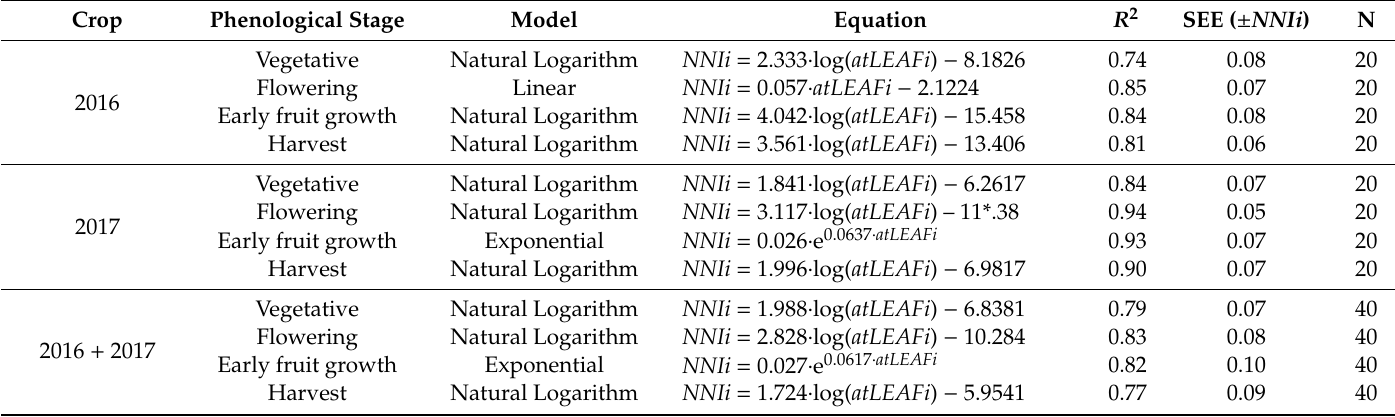
Table 7. Coe ffi cients of determination (R 2 ) of regressions between integrated atLEAF ( atLEAFi ) values and integrated nitrogen nutrition index ( NNIi ) for each phenological stage in each of the two sweet pepper ( Capsicum annuum ) crops independently and for the two crops together. Each crop was subjected to five di ff erent N treatments with four repetitions. According to the Akaike information criterion, the best-fit regression model (exponential, linear, power, quadratic, and natural logarithm) is shown. Also, it is presented the fitted equation and standard error of the estimate (SEE). All regressions were highly significant, with p -value < 0.001. N is the number of data points of